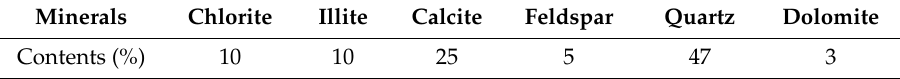
Table 1. Mineral composition of the Longmaxi shale samples.